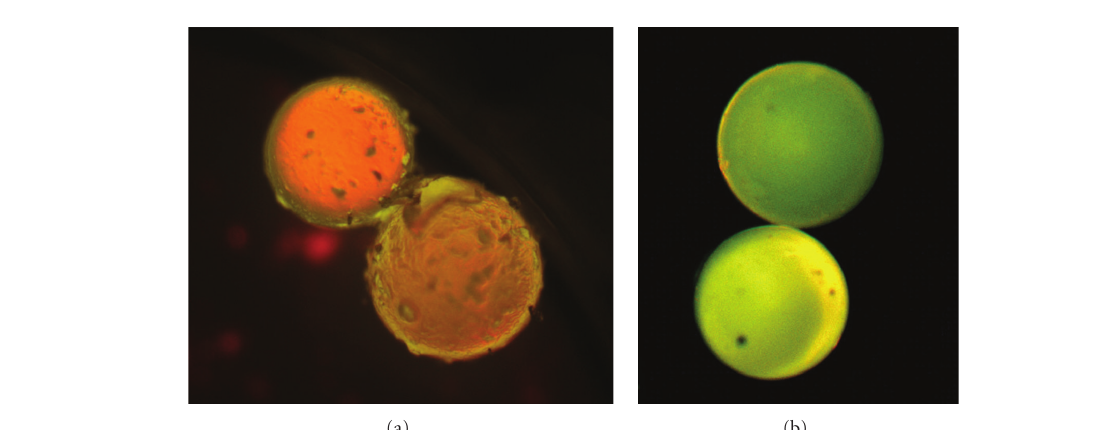
Figure 2: Representative pictures from screen of PAA library. The left hand picture represents a positive hit, while the picture on the right is a negative result within our